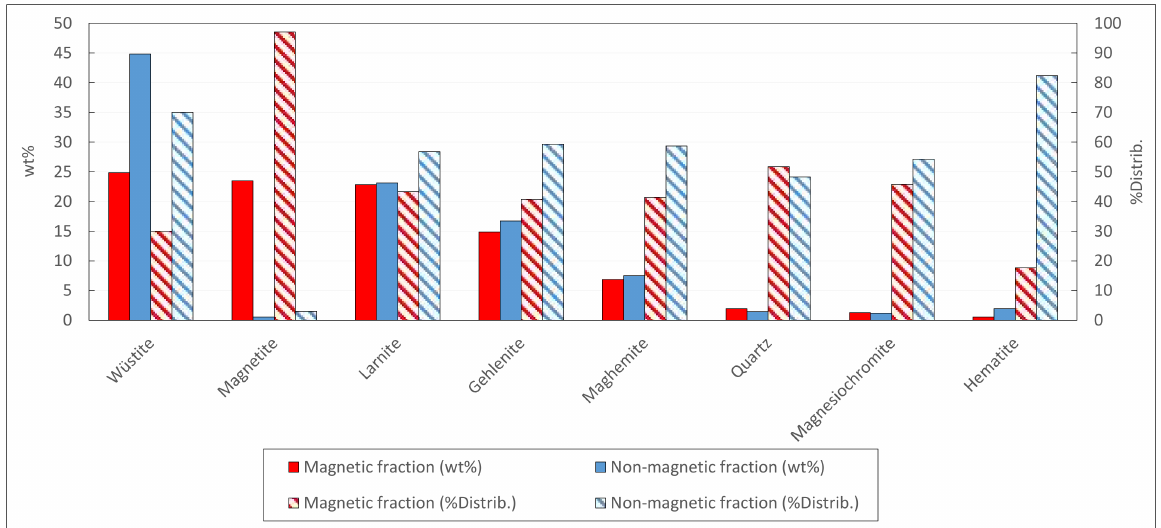
Figure 4. Mineral phases content and distribution in magnetic and non-magnetic fractions of the size fraction +0.25–1